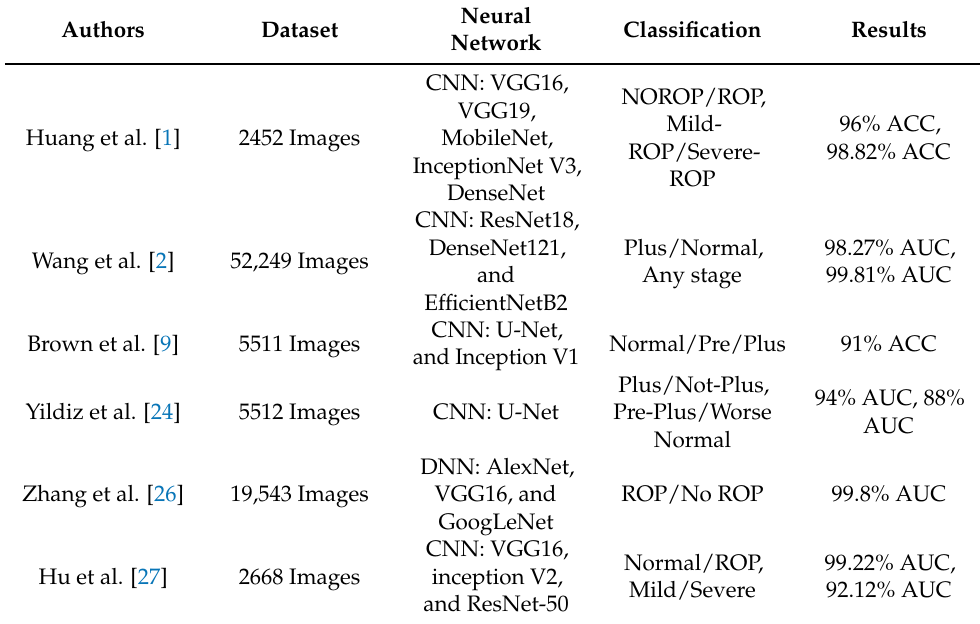
Table 1. Several studies on DL techniques in the field of